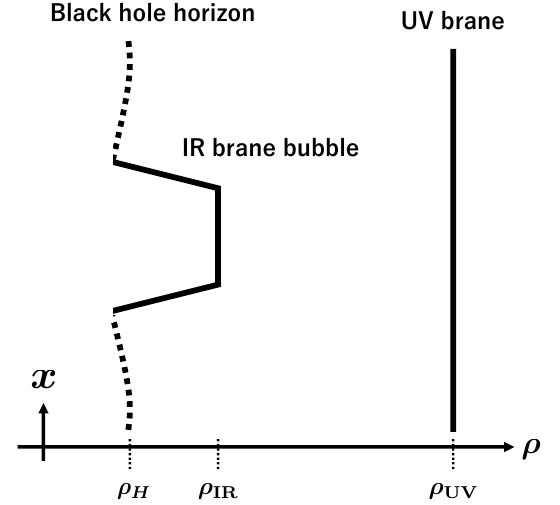
Figure 2 . The schematic description of the IR brane bubble nucleation. We here suppress two spatial dimensions and (cid:26) UV ; (cid:26) IR and T H denote the positions of the UV and IR branes and the event horizon of the AdS-S black